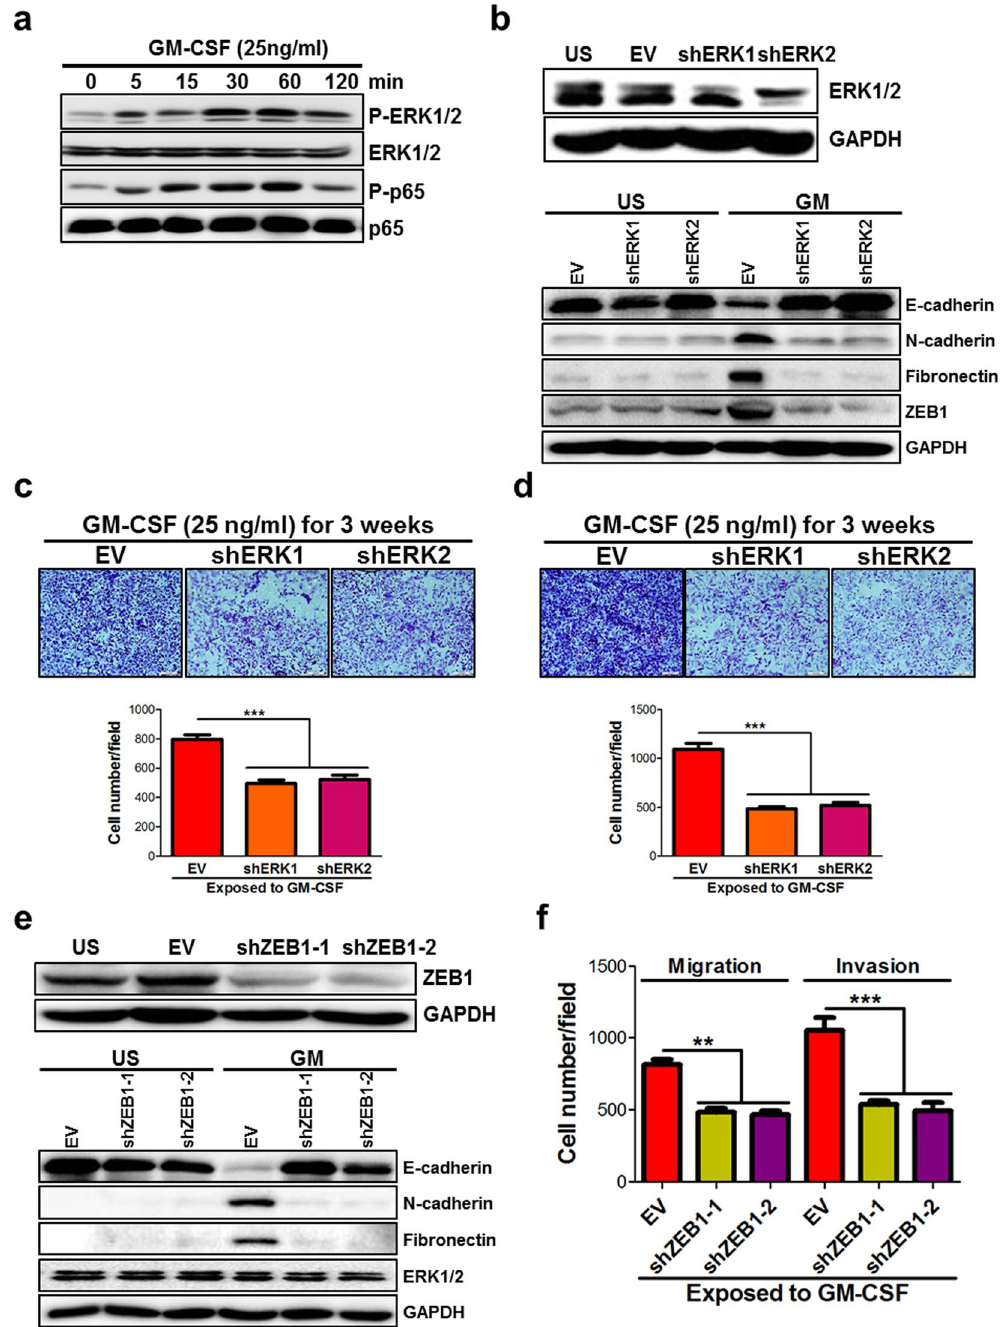
Figure 3. GM-CSF induces EMT program through MAPK/ERK-ZEB1 signaling pathway. ( a ) SW480 cell line was stimulated with GM-CSF (25 ng/ml) for 5–120 min. At the indicated timepoints, the proteins were extracted and the phosphorylation of ERK1/2 and NF- κ B p65 subunit was detected by immunoblotting. Representative data of cropped blots from three independent experiments were shown. ( b ) ERK1 and 2 in SW480 cell line were knockdown by RNA interference and cells were stimulated with GM-CSF (25 ng/ml) for three weeks. The expression of E-cadherin, N-cadherin, fibronectin and ZEB1 was examined by immunoblotting. Cropped blots were shown. ( c , d ) ERK1 and 2-knockdown SW480 cell line was treated with GM-CSF as described above. The ability of migration ( c ) and invasion ( d ) was detected by transwell experiments. ( e ) ZEB1 in SW480 cell line was knockdown by RNA interference and cells were stimulated with GM-CSF as described above. The expression of E-cadherin, N-cadherin, fibronectin and ERK1/2 was examined by immunoblotting. Cropped blots were shown. ( f ) ZEB1-knockdown SW480 cell line was treated with GM-CSF as described above. The ability of migration and invasion was detected by transwell experiments. Upper: representative images were shown. Bottom: the data were pooled from two experiments. EV: empty vector. ** P < 0.01; *** P < 0.001 vs EV